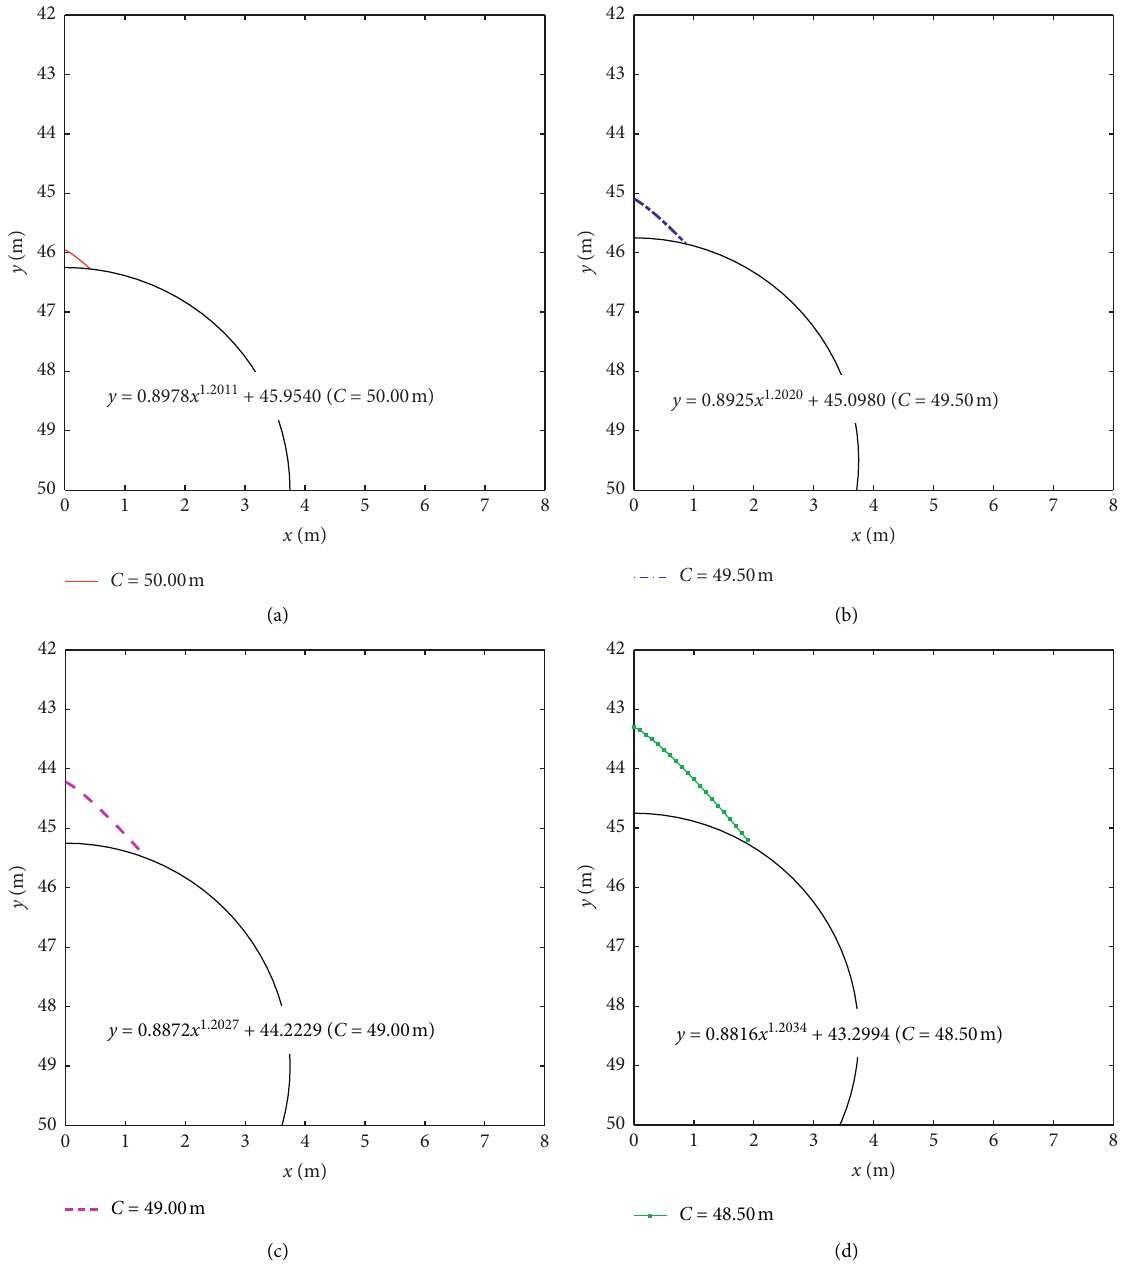
Figure 11: Effect of depth of tunnel axis C on collapse mechanisms. The parameters are A � 0.35, B � 5/6, σ 100 � 300kPa, h w � 0, h ( y � 50m) �− 16.68m, r � 3.75m, and c sat � 28.33kN/m 3 Figure 12. The limit analysis of the collapse mechanism for the shallow tunnel roof subjected to the pore water pressure can also be investigated by the proposed numerical ap- proach. The solving procedures of the numerical approach for shallow tunnels are slightly different from that of deep tunnels, and the main steps of the process are as follows. The work equation Ω � 0 and the variational equation δ Ω � 0 are the conditions to calculate the detaching surface of the collapsing block. For a shallow tunnel subjected to the pore water pressure, height H of the collapsing block is